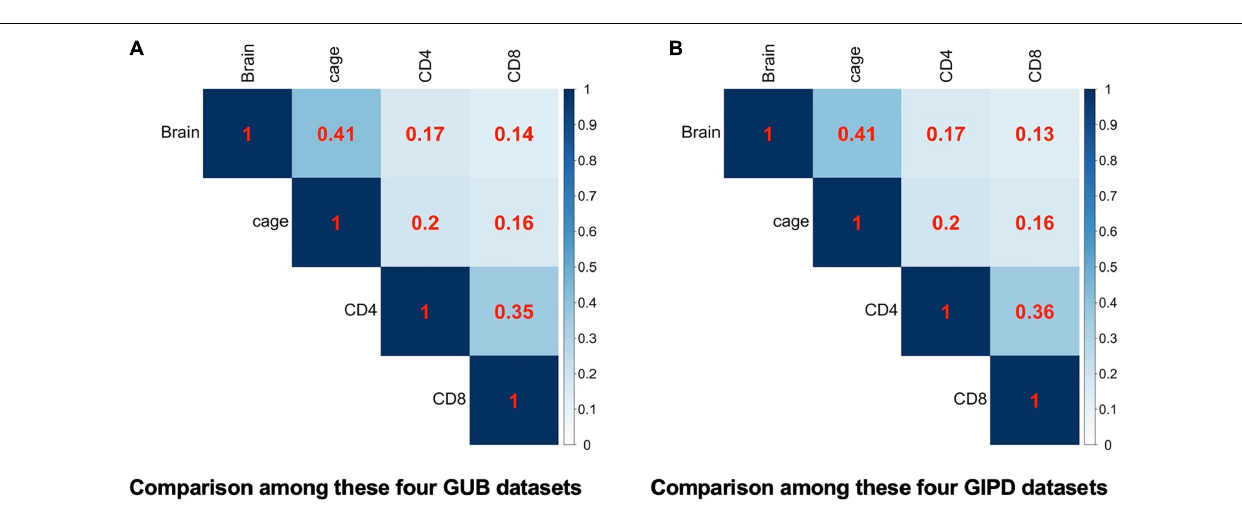
FIGURE 3 | (A) The heatmap of the four GUB data. (B) The heatmap of the four GIPD data. The correlation of these four different eQTL datasets were compared under the background of the same GWAS